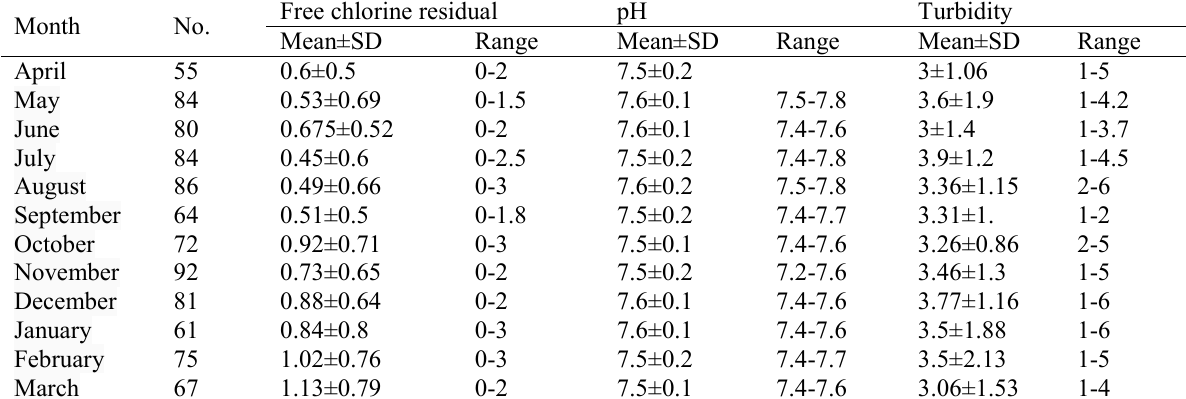
Table 1. Descriptive statistics and comparison of chlorine, pH, and turbidity in 12 months of 2017 in drinking water of Dasht-e Azadegan County